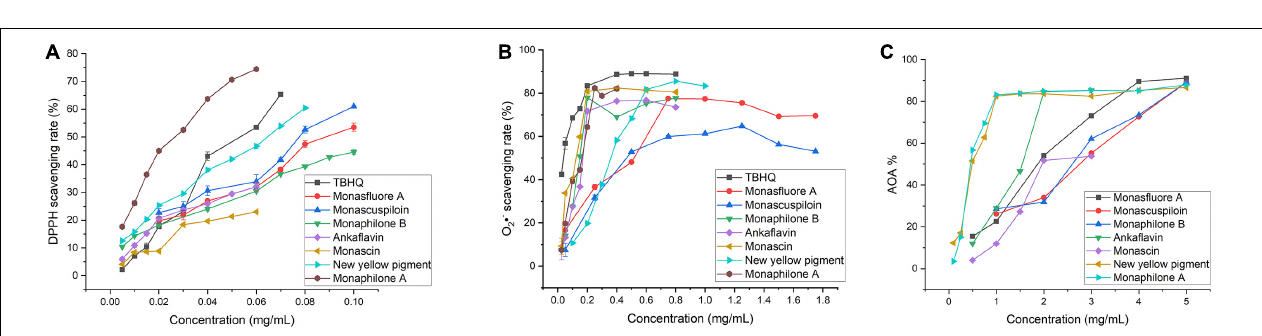
FIGURE 6 | Orthogonal projections to latent structures-discriminant analysis (OPLS-DA) of Monascus pigments composition of functional Qu (FQ) and coloring Qu (CQ), respectively. (A) Bioplot diagram of FQ (green hexagon), CQ (blue hexagon), and Monascus pigments (red, yellow, orange dots). (B) Permutation test diagram of OPLS-DA model ( R 2 = 0.421, Q 2 = –0.706). (C) VIP diagram. (D) HCA diagram.